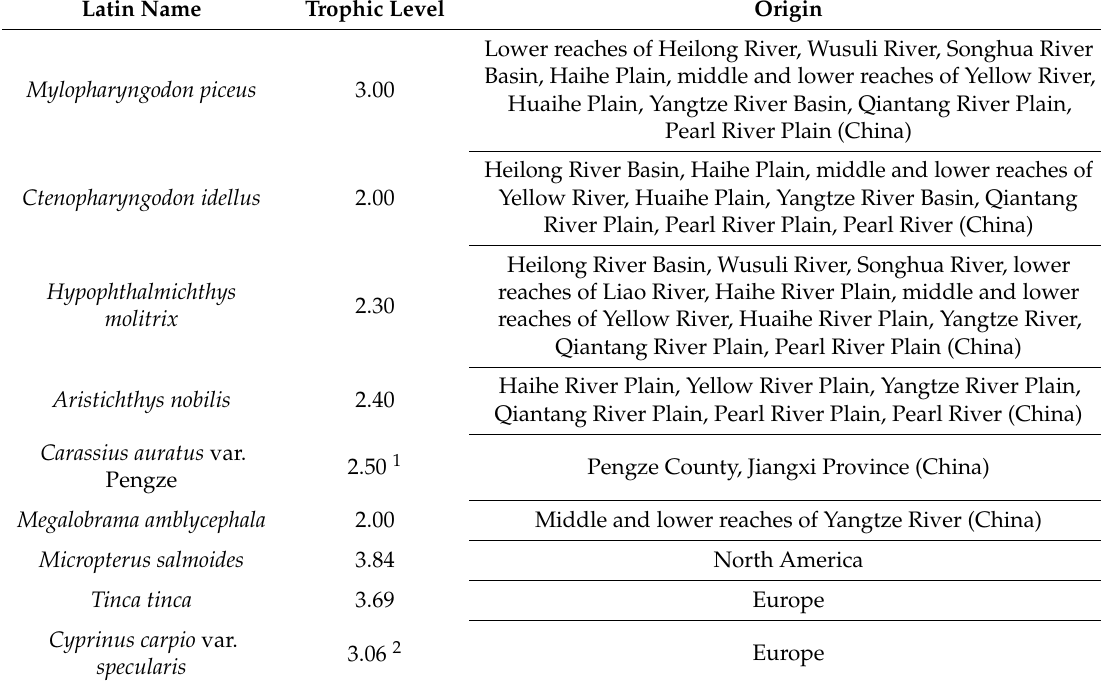
Table 2. The trophic levels of the non-native fish species ranged between 2.00 and 3.84 (Table 2). Table 2. List of non-native fish species in the Liao River